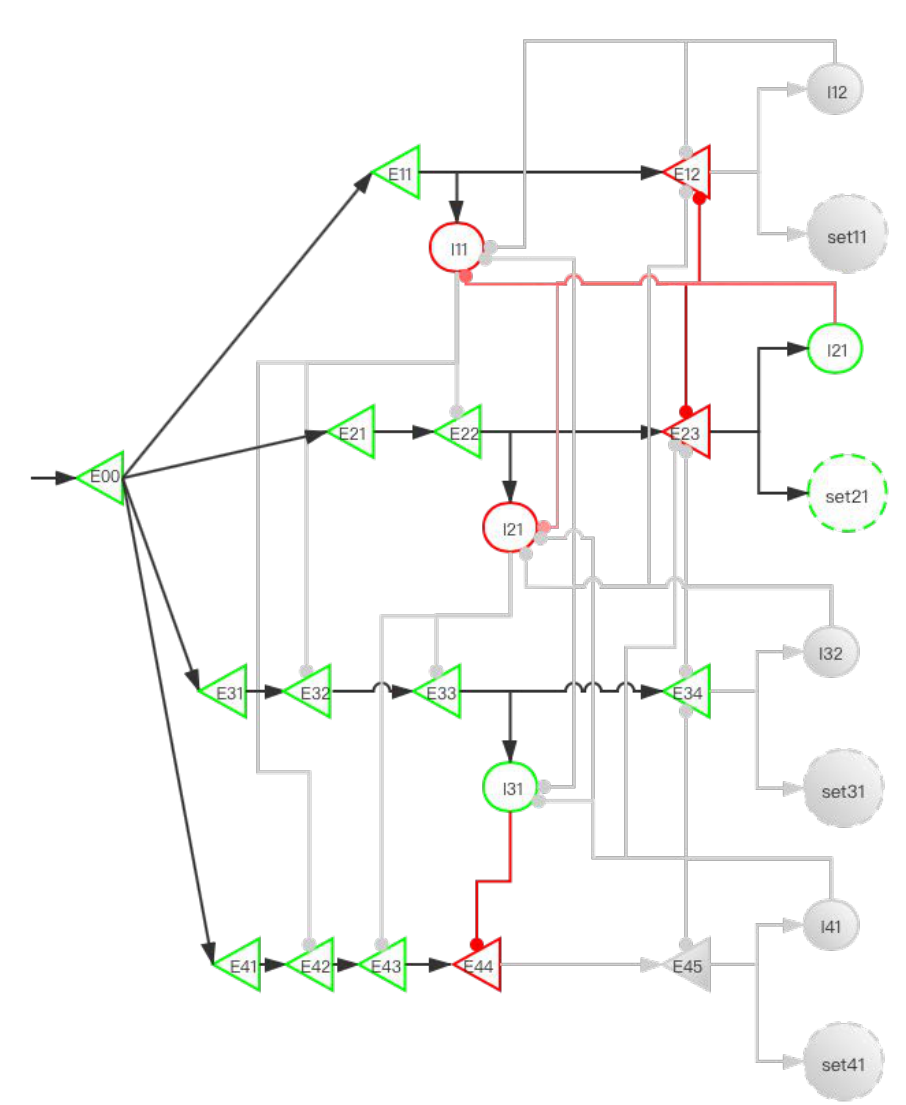
Figure 9. The activity of neurons in the time period from the activation of set21 by the second signal to the activation of E34 by the third signal (before set31 is activated). When E23 is activated, I22 inhibits I11 and I21. This prevents the next signal from entering the E11 branch and E21 branch to affect E31 and E41. The suppression of E12 and E23 by I22 increases the difficulty for set11 and set21 to be activated when set31 and set41 are not activated. After the third signal enters, at this time, the E11 and E21 branches have been locked, but the latter branches are still open and can be used for storage. E33 activates I31, and I31 is used to inhibit